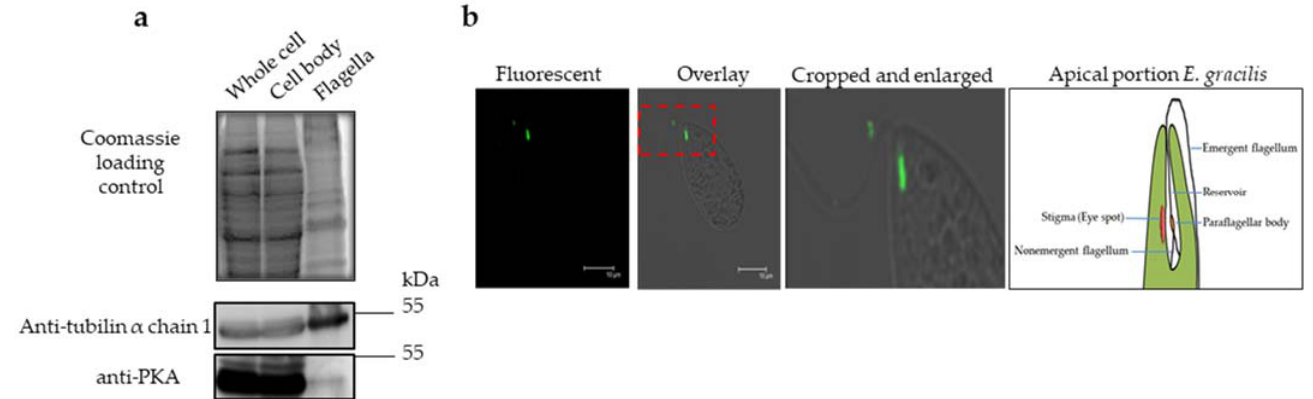
Figure 1. PKA localization in E. gracilis . ( a ) Western blots of the cell fractions. Coomassie loading control (upper panel), Western blot with tubulin antibody (middle panel), and PKA antibody (lower panel). ( b ) Fluorescent, overlay, and enlarged portion of the overlay image indicated by the dashed red rectangle as determined by the IIFA using the Anti-PKA antibody. Scale bar = 10 µ m. The right sketch image shows the major organelles in the apical portion of E. gracilis .